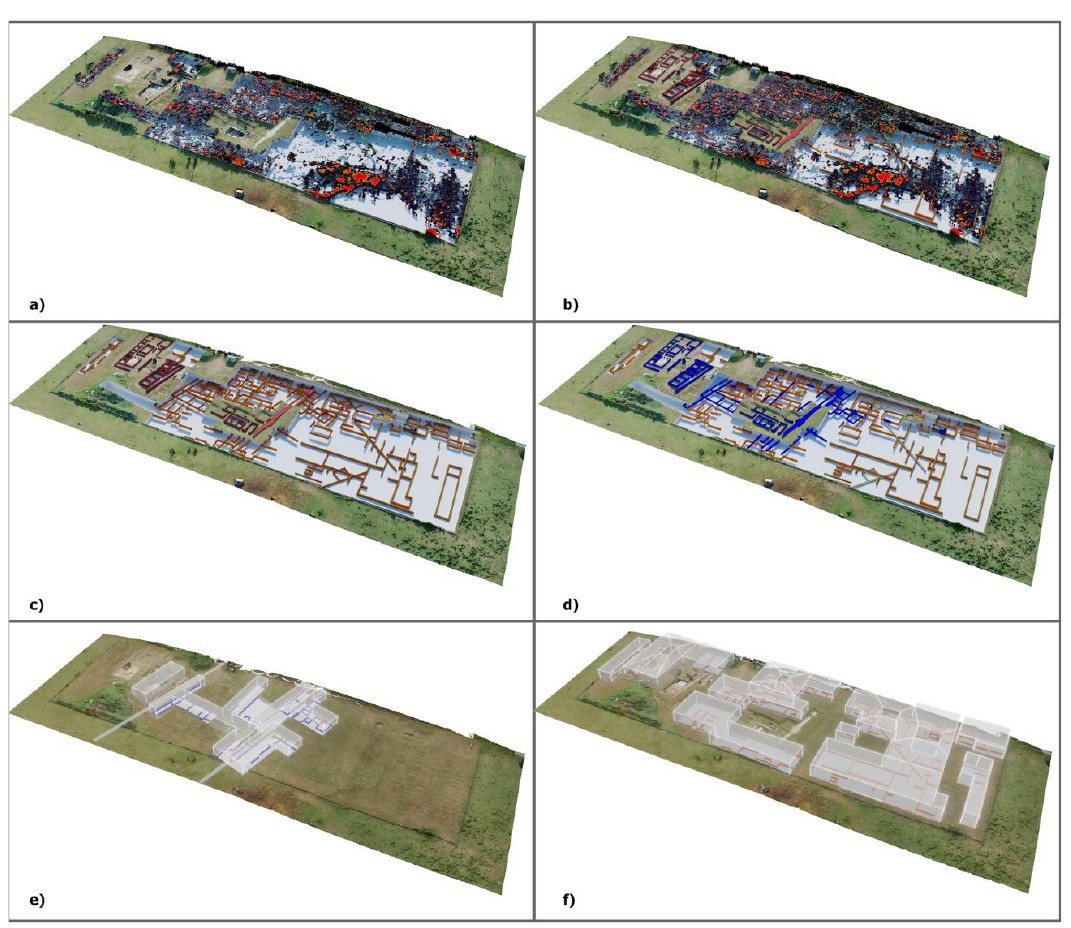
Figure 17. ( a ) GPR time-slices filtered in Blender 3D over sectioned photogrammetric model; ( b ) GPR time-slices filtered in Blender 3D and related proxies over sectioned photogrammetric model;